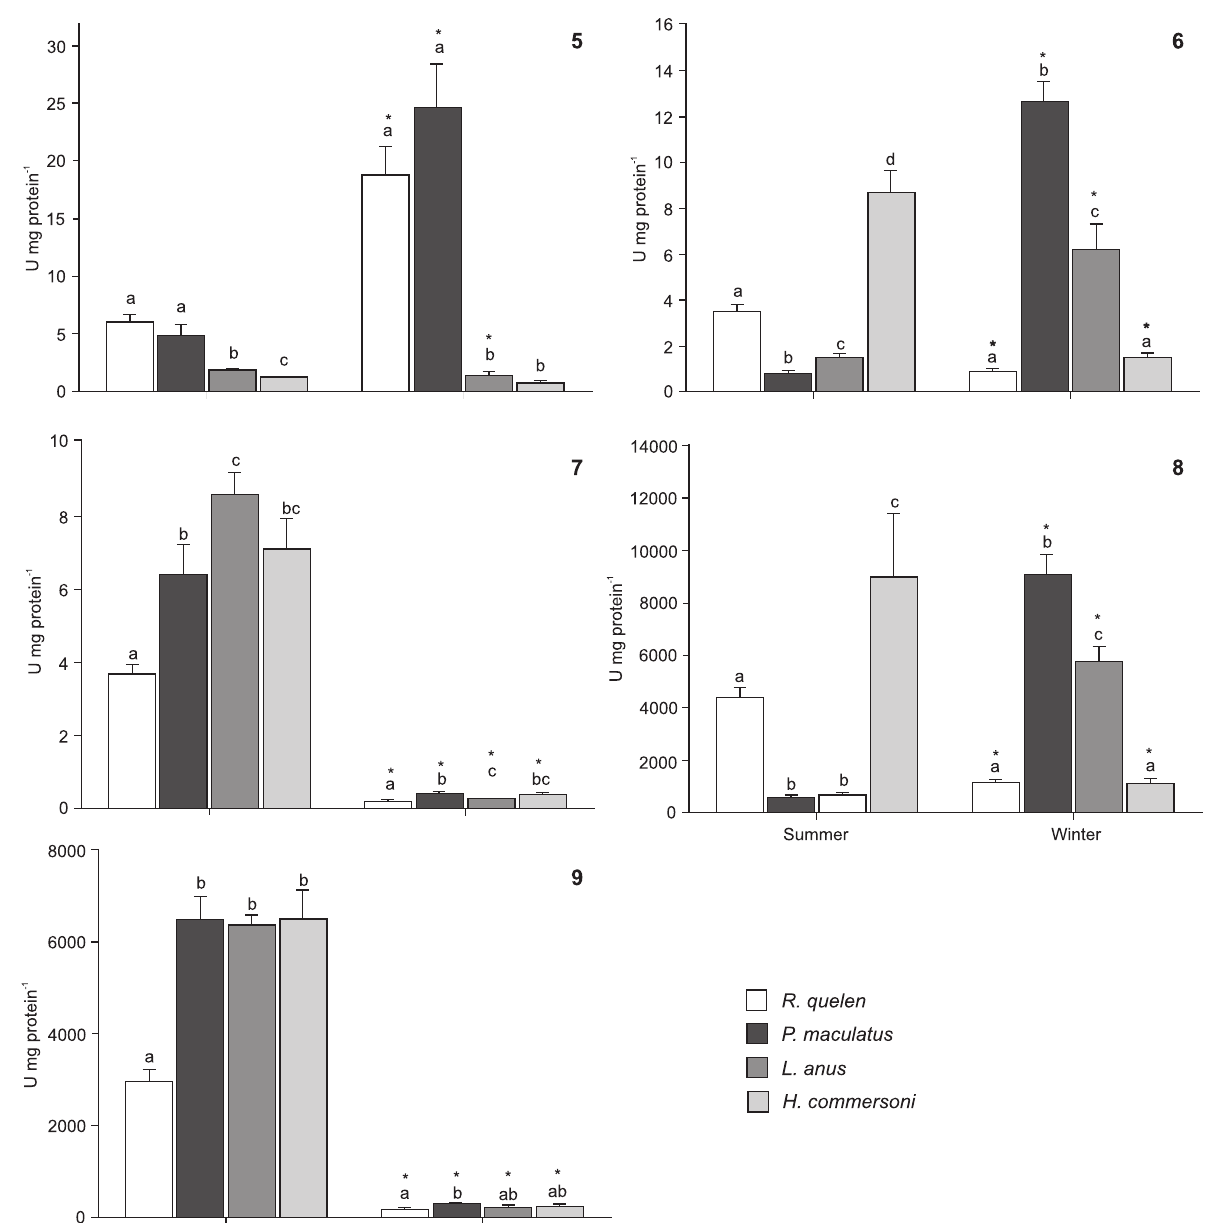
Figures 5–9. Proteolytic enzymatic activities in the omnivorous R. quelen and P. maculatus and detritivorous L. anus and H. commersoni in the summer and winter: (5) pepsin in the stomach; (6) trypsin in the anterior intestine; (7) trypsin in the posterior intestine; (8) chy- motrypsin in the anterior intestine; (9) chymotrypsin in the posterior intestine. Different letters indicate significant differences between species in the same season. * Indicates a significant difference from summer in the same segment (p < 0.05). (U, a Caraway unit) (n = 15 from each species at each